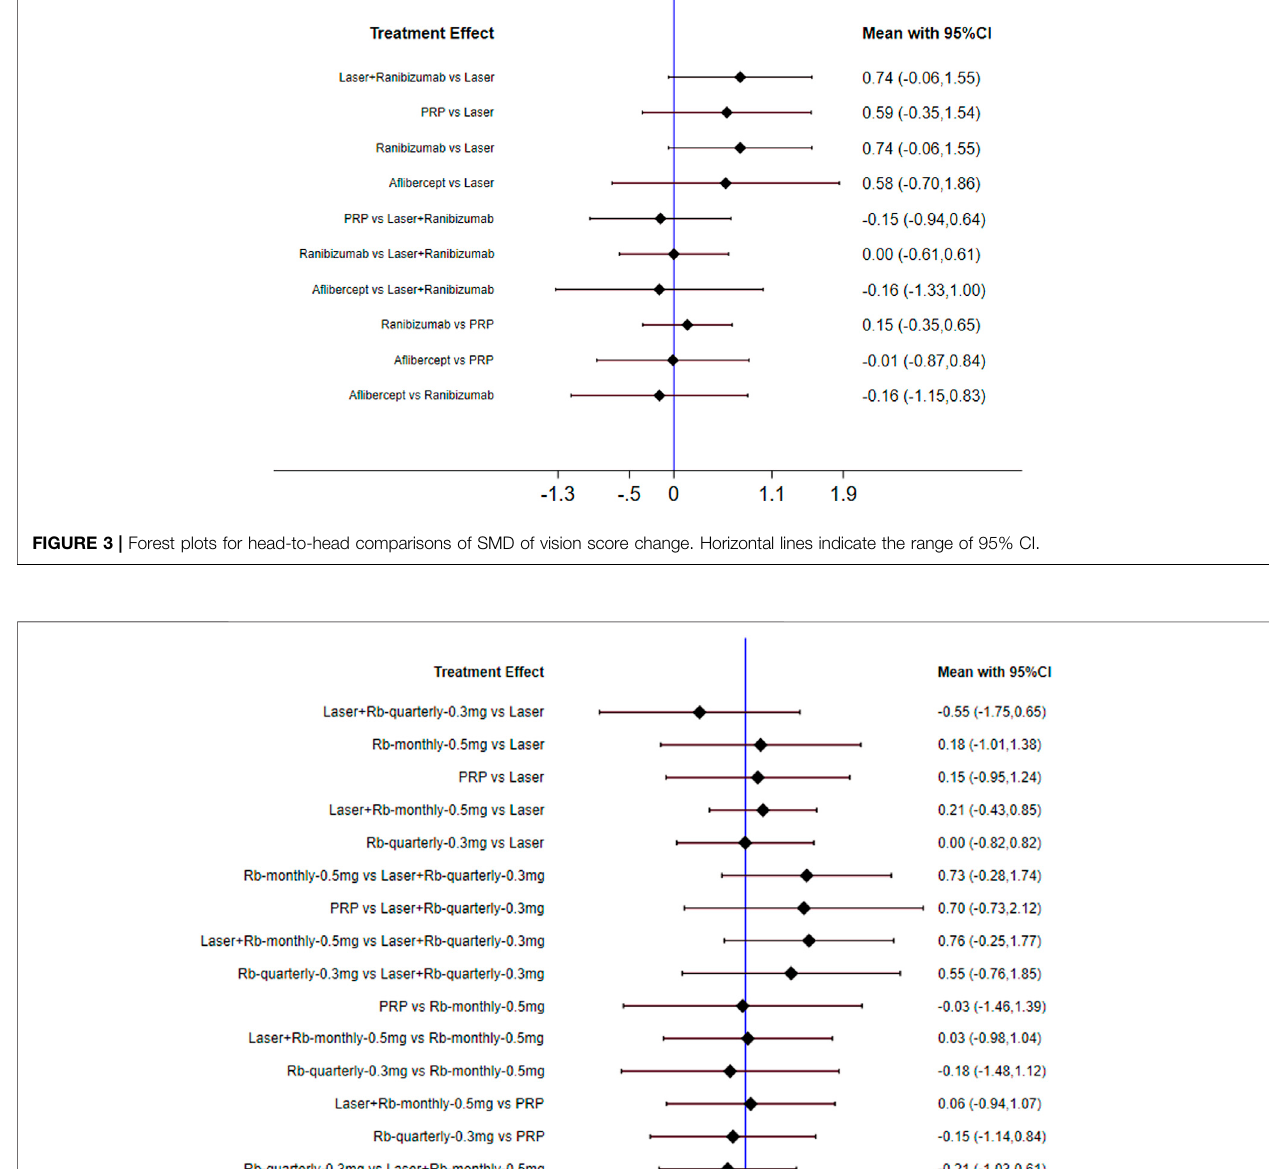
ranibizumab 0.3 mg/quarter, showing the vision improvement with the largest gap [laser + ranibizumab 0.5 mg/month vs laser + ranibizumab 0.3 mg/quarter: SMD (cid:1) 0.76; 95% CI ( − 0.25, 1.77)], but the effect of laser + ranibizumab 0.3 mg per quarter was the worst than laser [laser + ranibizumab 0.5 mg/quarter vs laser: SMD (cid:1) − 0.55; 95% CI ( − 1.73, 0.65)] ( Figure 4 ). Other results are shown in Supplementary Appendices 7 – 18 .